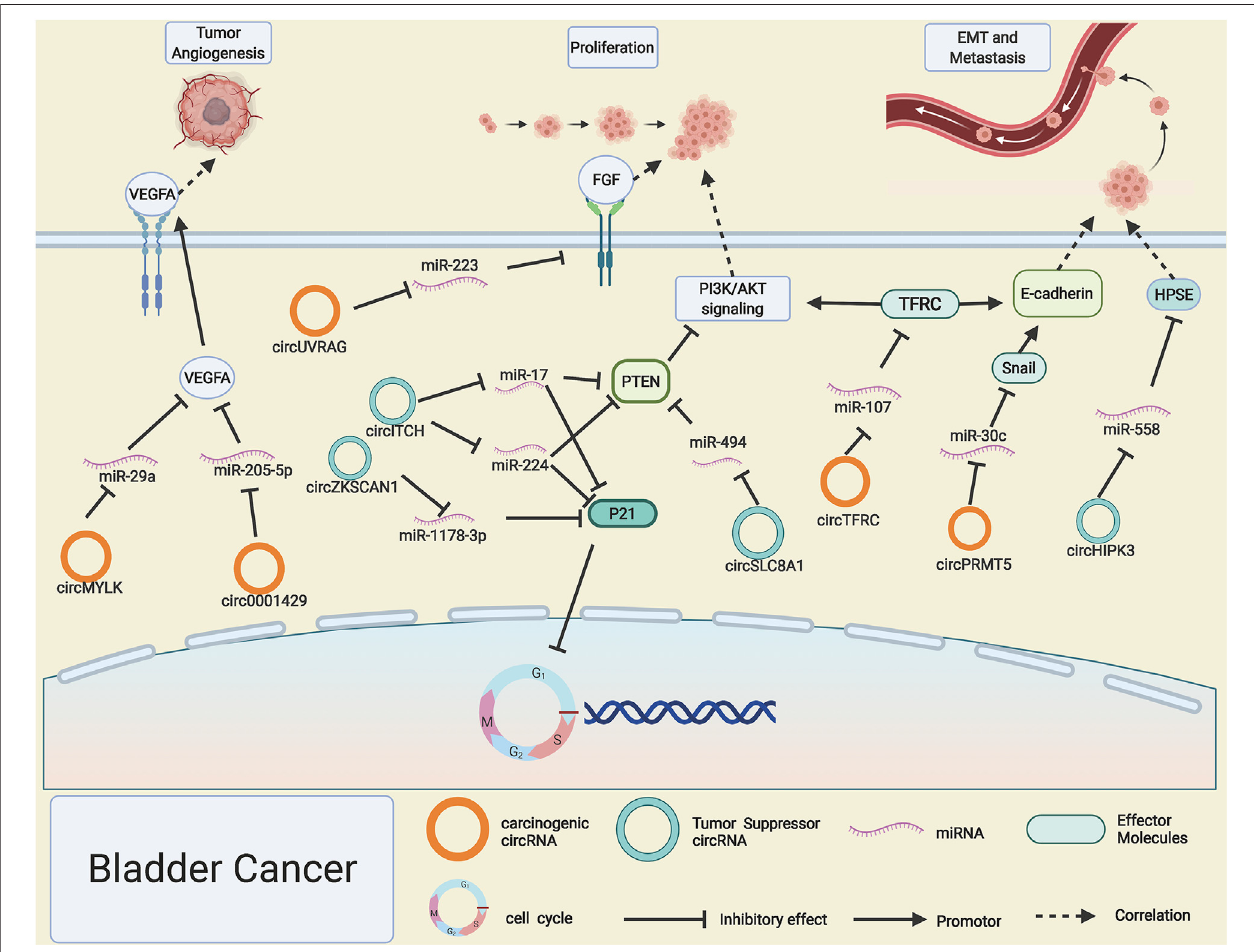
FIGURE3 | Possible mechanisms ofcircRNAs in bladder cancer.Upregulated circMYLK, circ0001429, circUVRAG,circTFRC, and circPRMT5(orange rings) and downregulatedcircHIPK3,circSLC8A1,circ-ITCH,andcirc-ZKSCAN1(cyanrings)regulateprogressionofbladdercancerbyalteringspeci fi cgeneexpressionortumor- related signaling